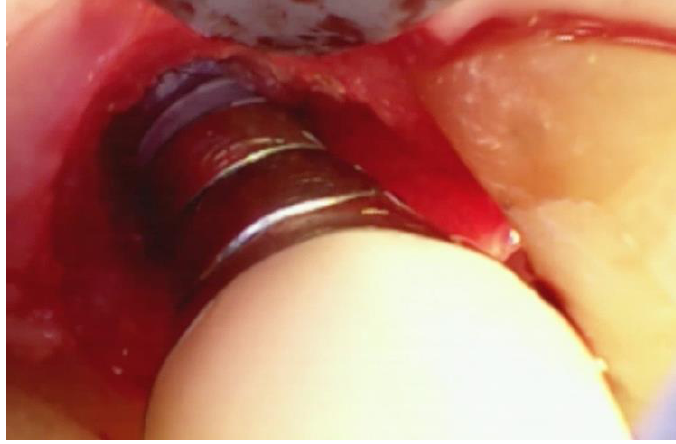
Figure 8. The fully debrided bony lesion can be visualized after removal of the granulation tissue. After the lesion is debrided of granulation tissue and the implant is cleaned with saline, DFDBA mixed with EMD is place in the bony defect. (Figure 9).